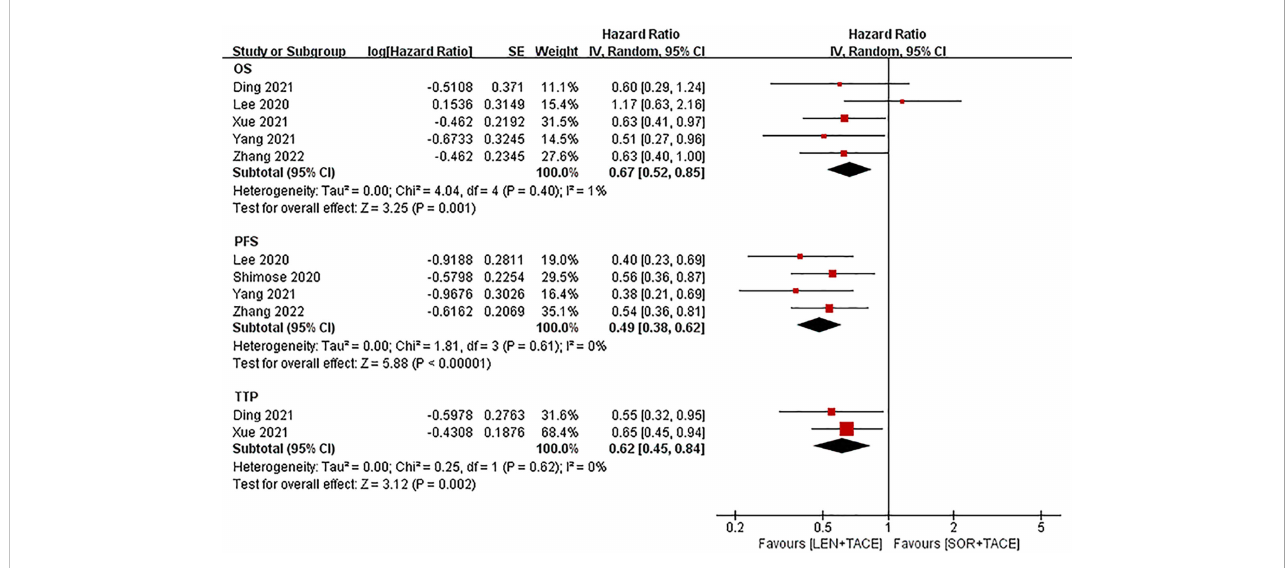
FIGURE 3 Forest plots for the comparison of overall survival (OS), progression free survival (PFS) and time to progression